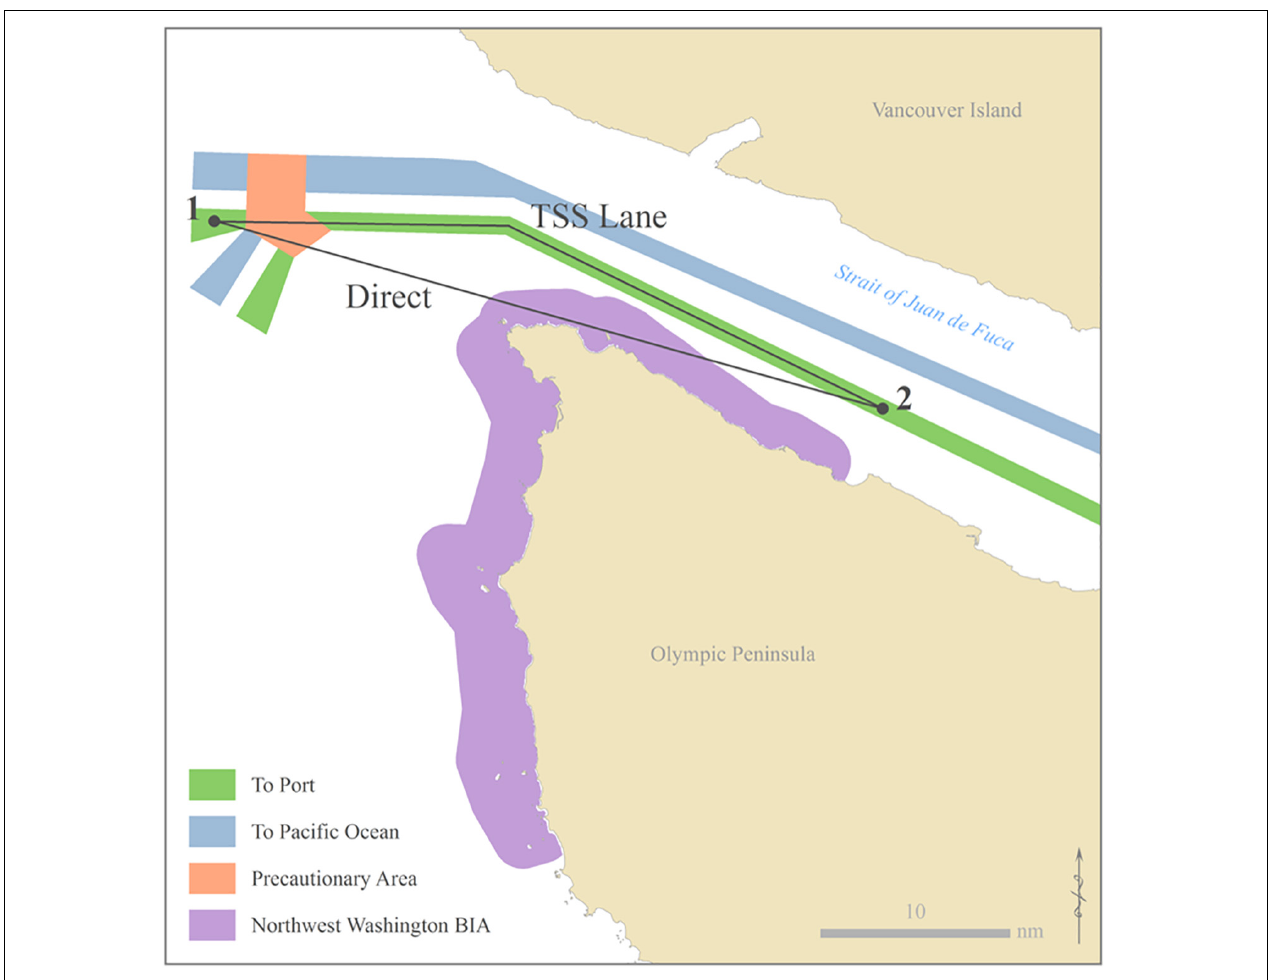
FIGURE 6 | Potential vessel transit lines cutting across the Northwest Washington Biologically Important Area (BIA) due to temporal gaps between sequential points in the SAIS data, (1) and (2). The vessel could actually remain inside the Traffic Separation Scheme (TSS), but could appear to cut across the BIA, leading to false